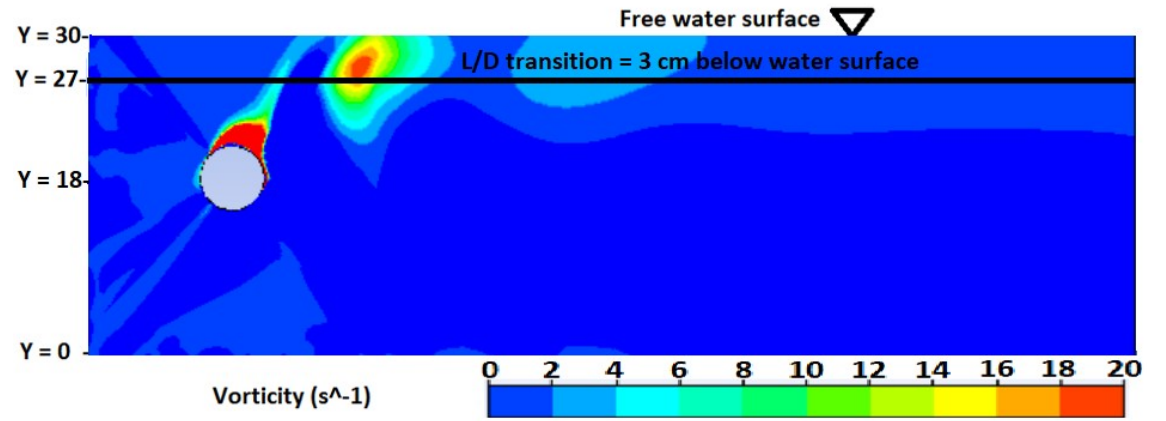
Figure 11. Vorticity field created by cylinder oscillation when cylinder is at its lowermost position.